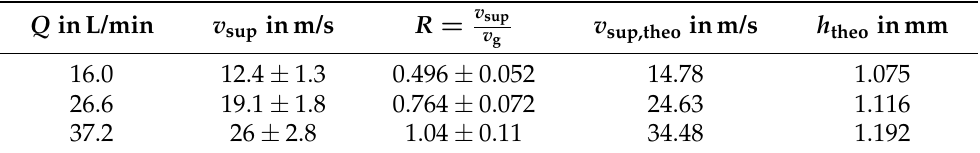
Table 4. Measured flow velocities of the MWF supply flow v sup and velocity ratio R for the used volume flows Q and added theoretical nozzle heights h theo to discuss the deviation to the theoretical MWF supply flow velocities v sup,theo